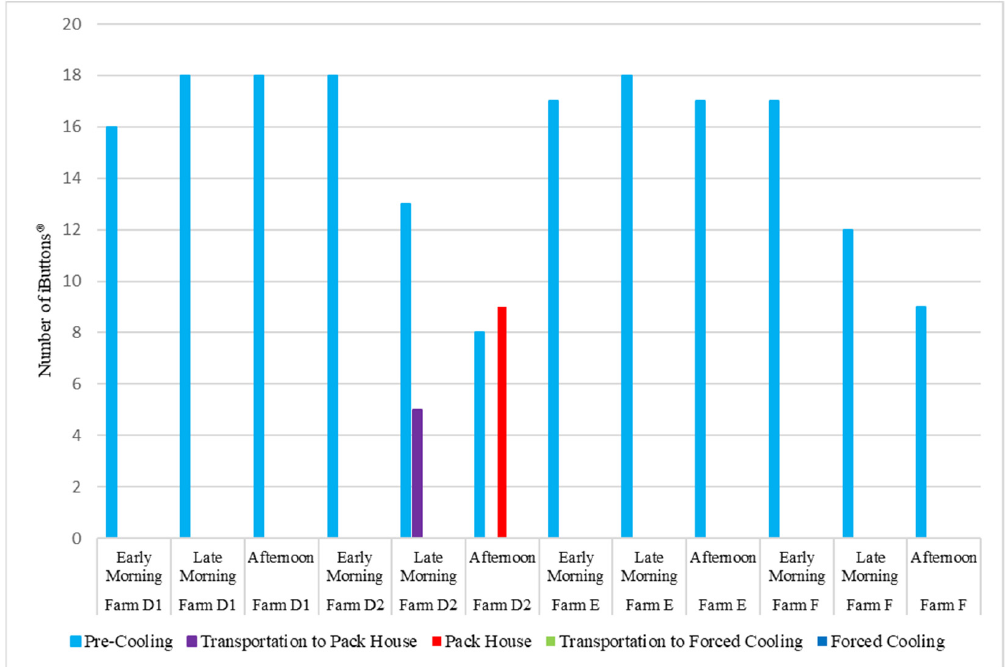
Figure 8. Stage during which PT = 6 °C was reached on Western Cape farms. Source: [13].